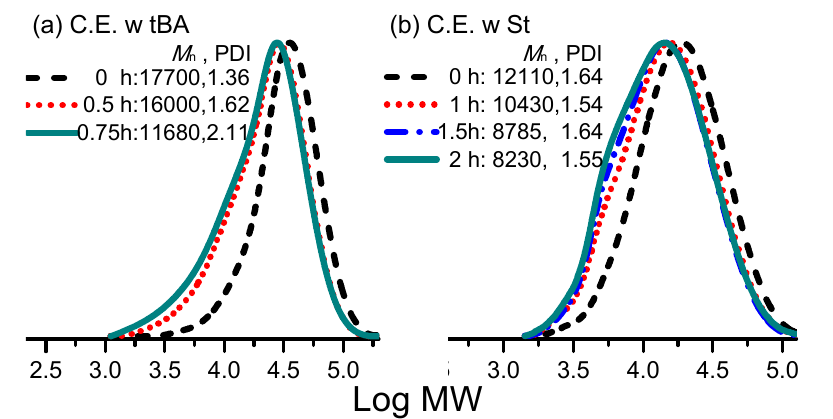
Figure 5. GPC traces of the corresponding chain extensions of homo-stars with ( a ) tBA and ( b ) St monomers at 125 °C (M/MI = 80/1).